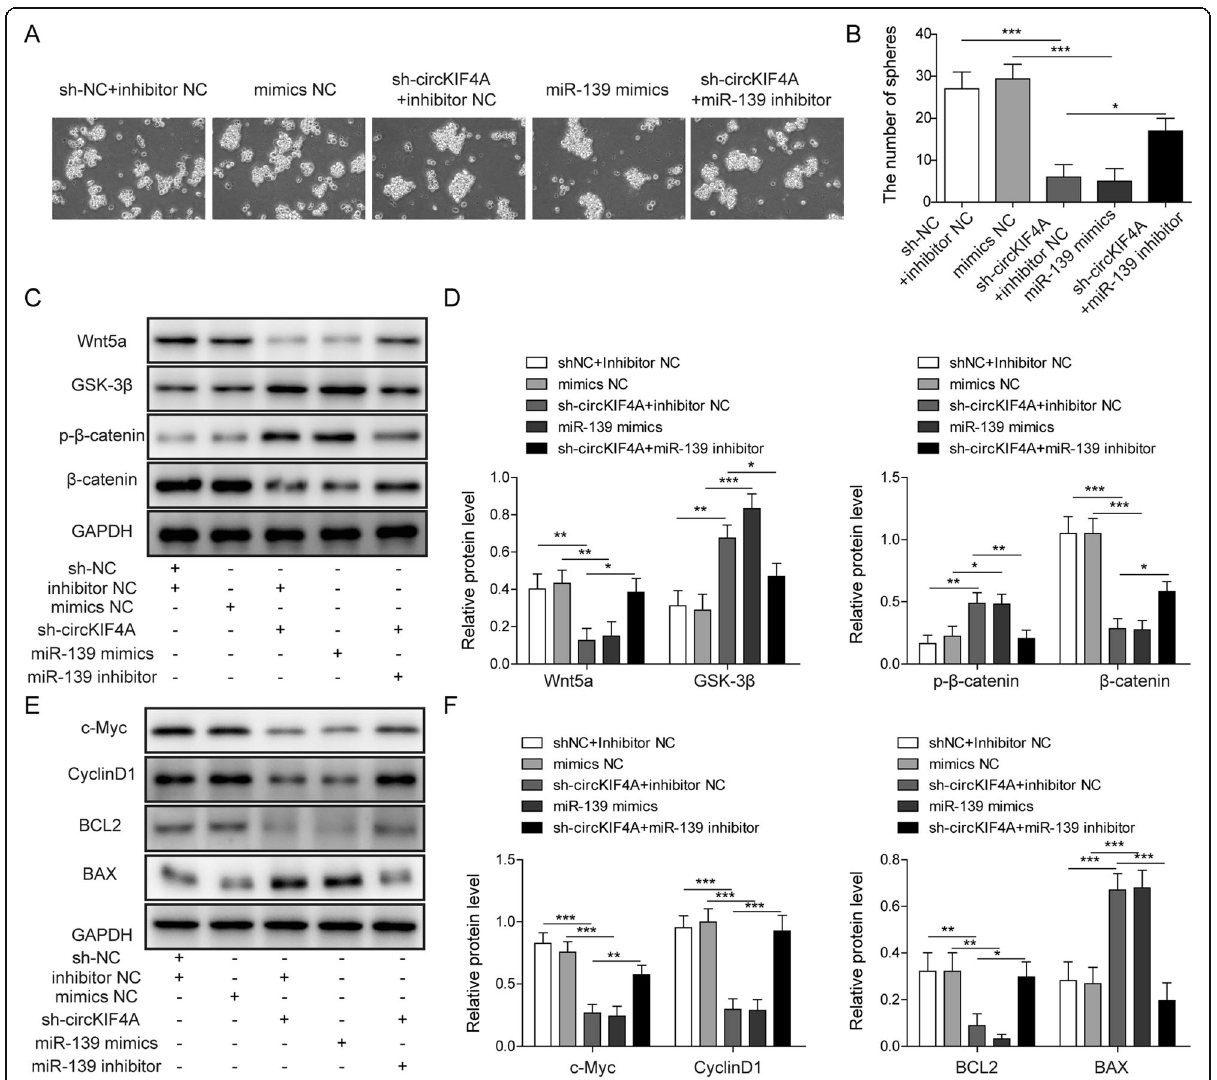
Fig. 6 circKIF4A knockdown suppressed the spheroid formation of GICs through miR-139-3p/Wnt5a signaling. After transfecting GICs with sh- circKIF4A, miR-139-3p mimics or miR-139-3p inhibitors, a the sphere growth of GICs was determined by sphere formation assays. b Quantitative analysis of the GICs sphere number. c The protein expression of Wnt5a, GSK-3 β , β -catenin and p- β -catenin were detected by Western blotting. d The quantification of Wnt5a, GSK-3 β , β -catenin and p- β -catenin relative protein level as a ratio to that of GAPDH (internal control). e The protein expression of c-Myc, cyclin D1, Bcl2 and Bax were detected by Western blotting. f The quantification of c-Myc, cyclin D1, Bcl2 and Bax relative protein level as a ratio to that of GAPDH (internal control).* p < 0.05, ** p < 0.01, *** p <